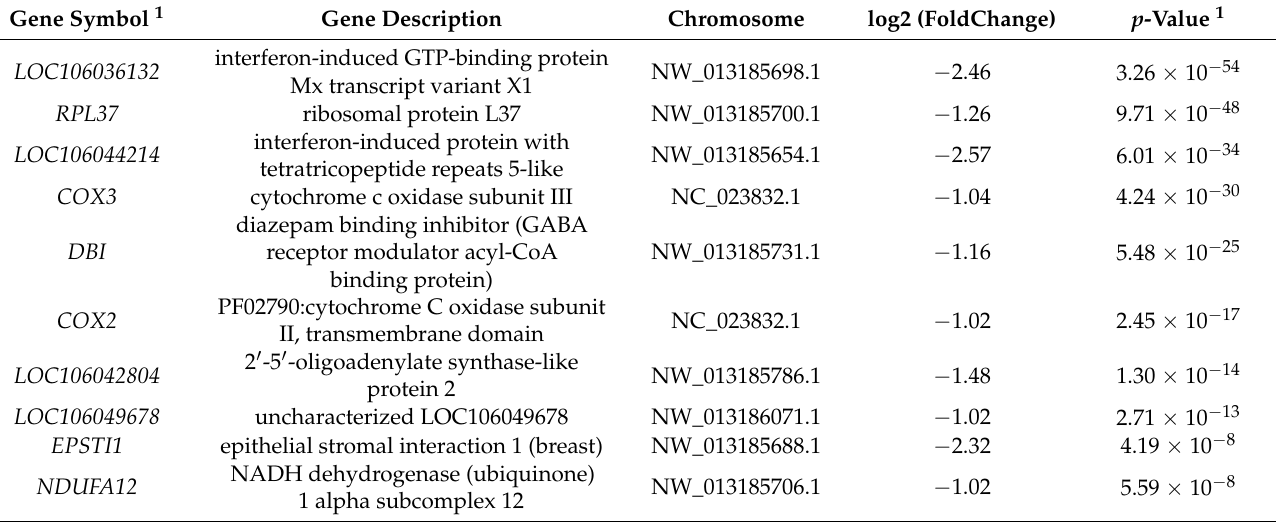
Table 5. Top 10 downregulated